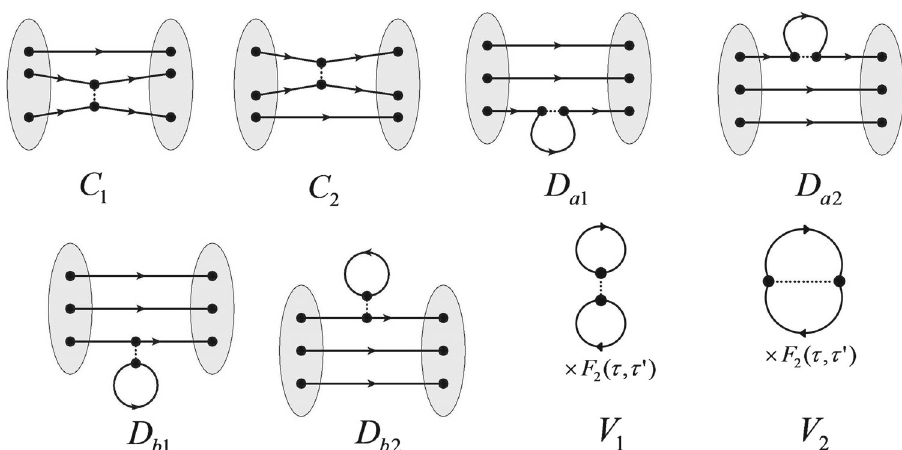
Fig. 2 List of contraction diagrams. In each diagram, the ellipses at the left and the right represent ¯ χ( q 1 , q 2 , q 3 ; (cid:2) x (cid:9) ,τ (cid:9) ) and χ( q 1 , q 2 , q 3 ; (cid:2) x ,τ) , respectively, whereas the solid lines represent the contractions between quark fields and the short dashed line denotes the four-quark vertex at ( (cid:2) x 0 ,τ 0